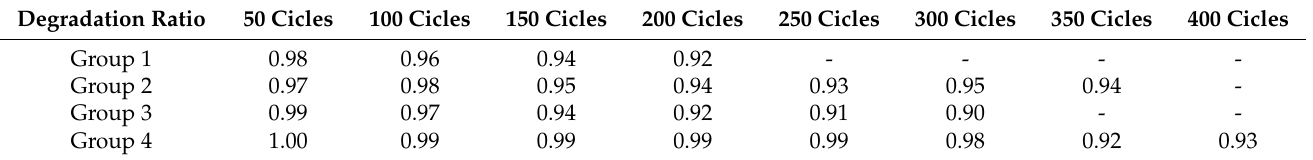
Table 7. Average degradation ratio for batteries of the four groups.